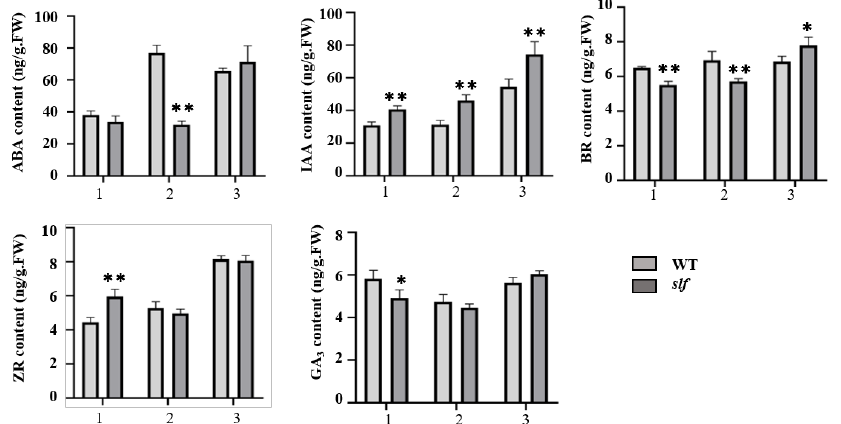
Figure 2. The contents of ABA, IAA, ZR, BR and GA3 in WT (14–345) and slf leaves at the fourth- leaf stage (1), fifth-leaf stage (2) and seventh-leaf stage (3). Asterisks denote significant differences (* p < 0.05; ** p < 0.01) as determined by Student’s t -tests.